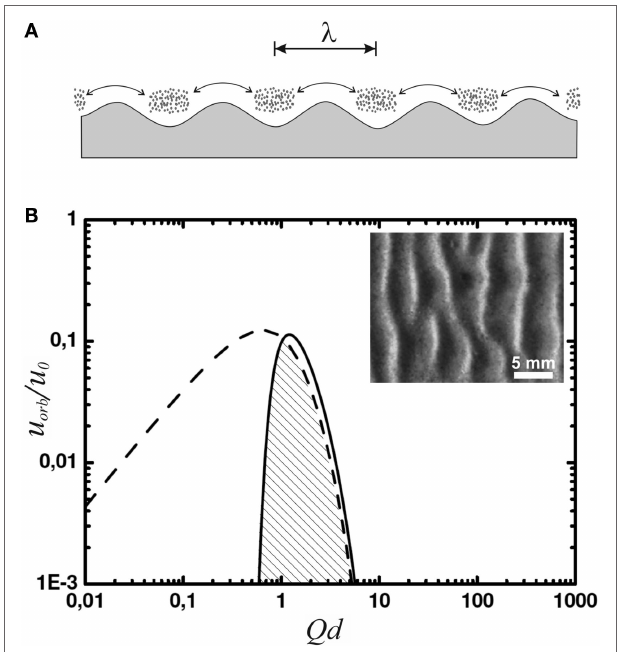
FIGURE 3 | (A) Sketch of lumps of microbial material at the sea floor, agitated in an oscillatory manner with a peak-to-peak amplitude indicated by the double arrow. Gravity accumulates microbial material in the troughs of the sea floor profile, and the lumps thus forming deepen in turn the sea floor troughs. (B) The orbital velocity spectrum (solid curve) and its limit due to wave breaking (dashed curve). The inset shows a top view of a ripple obtained in the corresponding experiments [adapted with modification from ref. Mariotti et al.